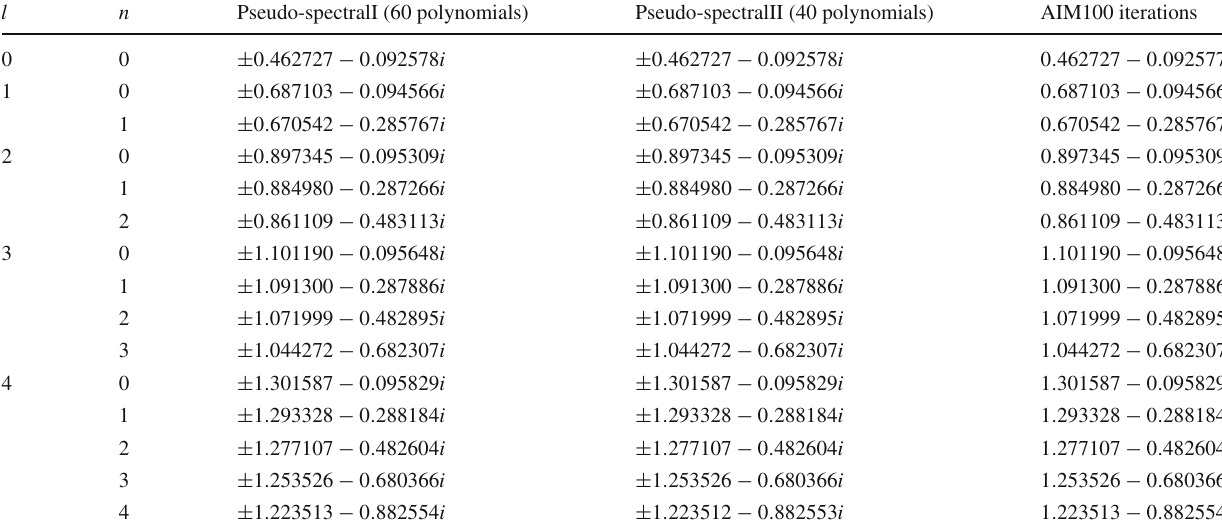
Table 7 Quasinormal frequencies of spin 5 / 2 perturbations normalized by the mass ( M